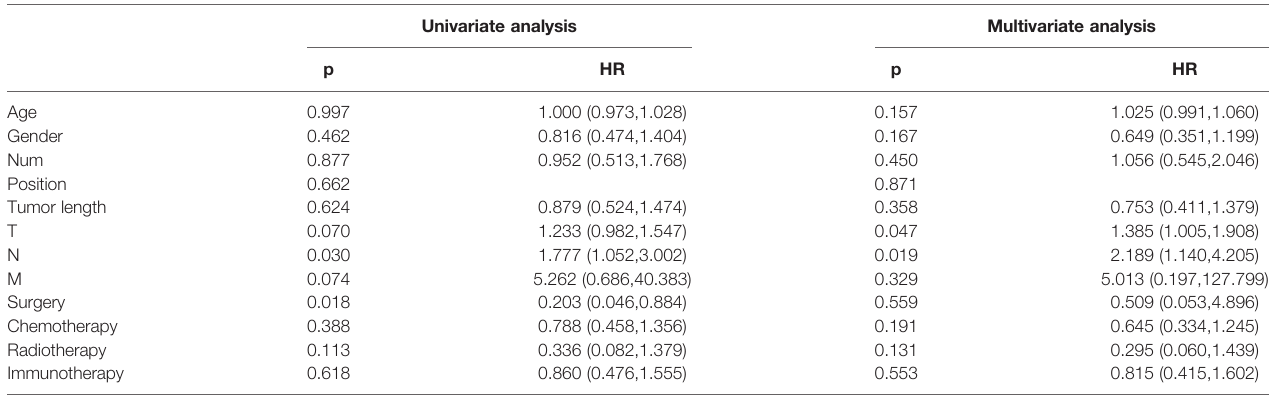
TABLE 4 | Univariate and Multivariate Analyses of Predictive Factors for Overall